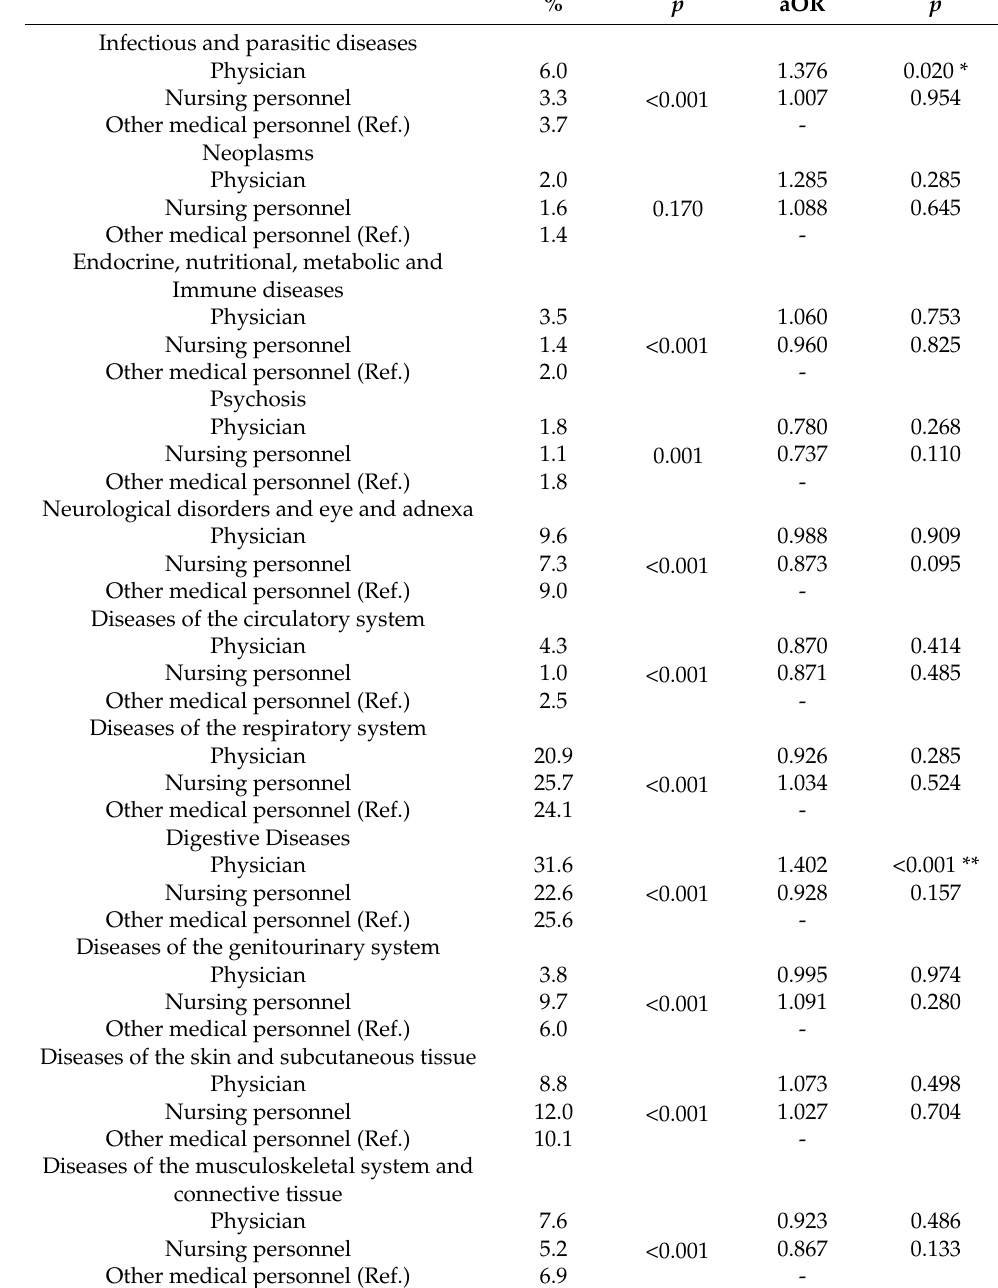
Table 3. Association of different medical provider in Taiwan with systemic diseases (N =